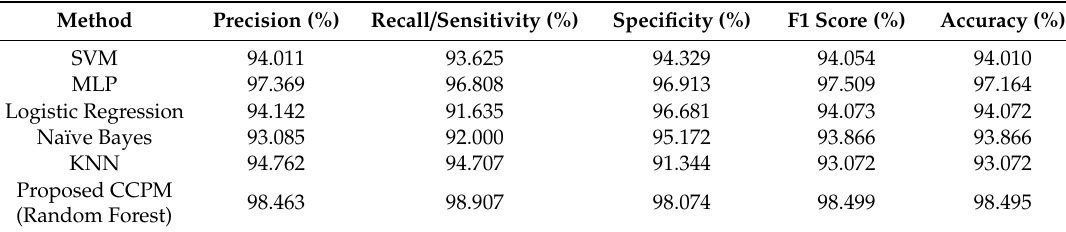
Table 13. Performance evaluation results based on iForest and SMOTETomek for Schiller.